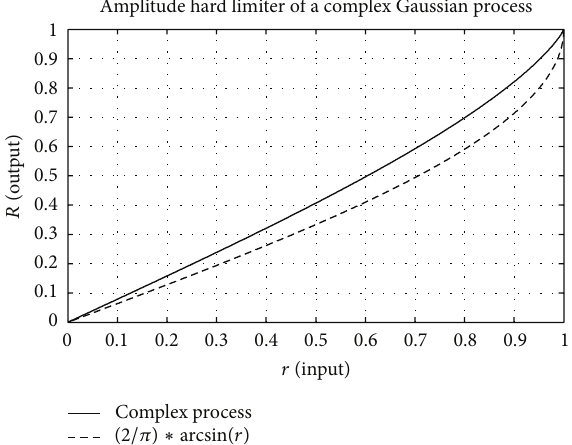
Figure 6: Output autocorrelation ( 𝑅 ) from a hard limiter versus the input autocorrelation ( 𝑟 ).